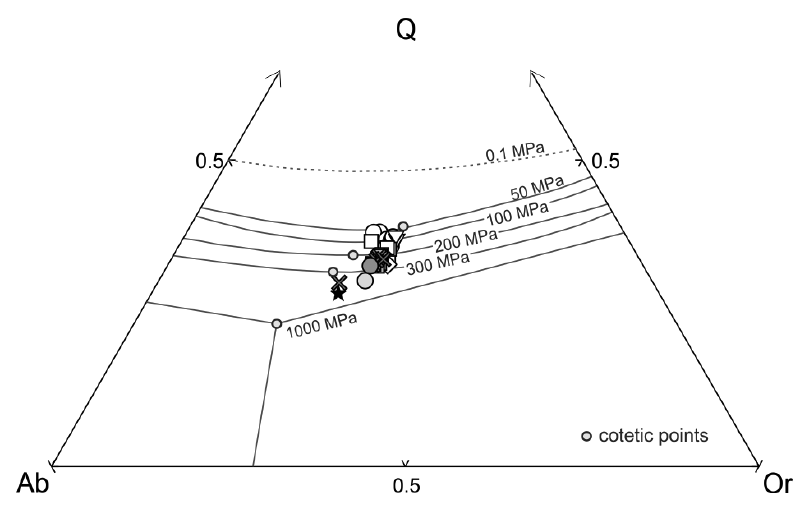
Figure 11 - Normative compositions for selected samples of the Quiriri and Papanduva Plutons in the haplogranitic Or-Ab-Qz ternary system. Units are weight fractions. Silica-feldspar cotetics from Blundy and Cashman (2001). Symbols as in Fig